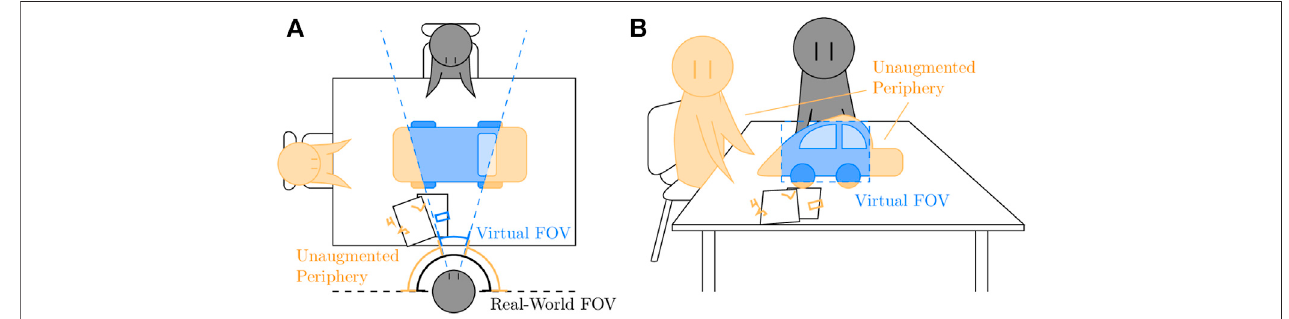
FIGURE 1 | Diagram of virtual and real-world fi elds of view. Virtual objects are drawn in blue and orange. Panel (A) shows a bird ’ s-eye view of a team collaborating over a table. On the table is a virtual object. The virtual FOV (blue dotted lines) is smaller than the real-world FOV (short grey lines), leading to large sections of virtual content in the unaugmented periphery (orange). Panel (B) shows a fi rst-person view, denoting the virtual FOV (blue) and unaugmented periphery (orange). The grey character is visible, being physically present, while the orange character is not visible, being in the unaugmented periphery.